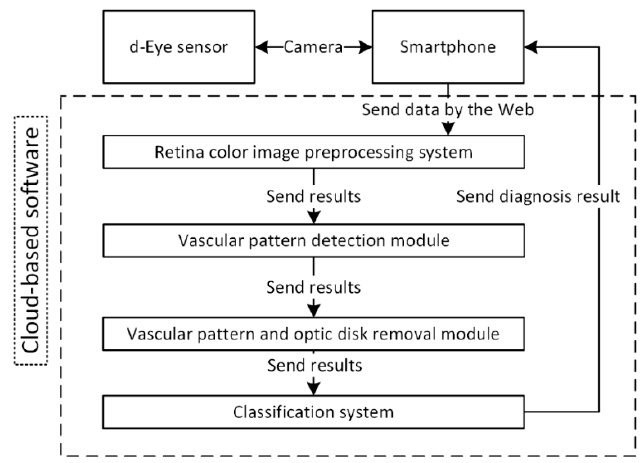
Figure 1. The architecture of the proposed system.